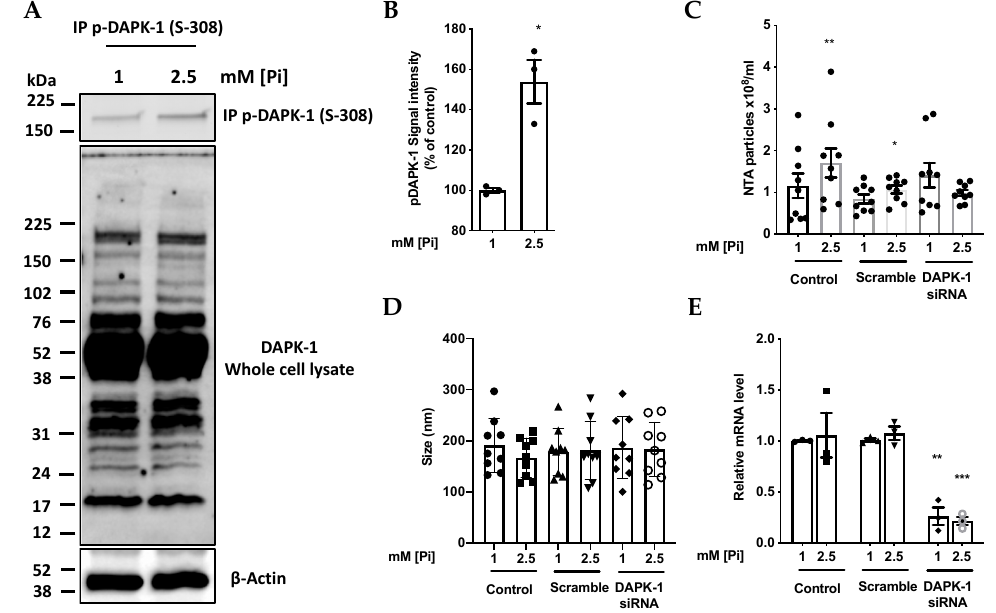
Figure 3. Pi induces an increase in phosphorylation of DAPK-1. ( A ) Endogenous human DAPK-1 was immuno-precipitated from cell lysates (200 µ g total cellular protein) from cells treated with 1 or 2.5 mM Pi for 1.5 h. Immuno-precipitated DAPK-1 was subjected to immuno-blotting with phosphospecific antibody against p-(S308)-DAPK-1. ( B ) Densitometry analysis of ( A ), n = 3, * p = 0.037. ( C ) Partial silencing of DAPK-1 blunts the e ff ect of elevated Pi concentration on MV release detected by NanoSight Nanoparticle Tracking Analysis (NTA). Each pair of data points refer to a separate multiwall plate, n = 4, * p = 0.015, ** p = 0.0035, ( D ) Size of particles released from cultures in response to Pi-loading for 1.5 h as in ( C ) measured by NTA. ( E ) Relative mRNA level of DAPK-1 confirming siRNA silencing of DAPK-1as indicated in ( B – D ), *** p =